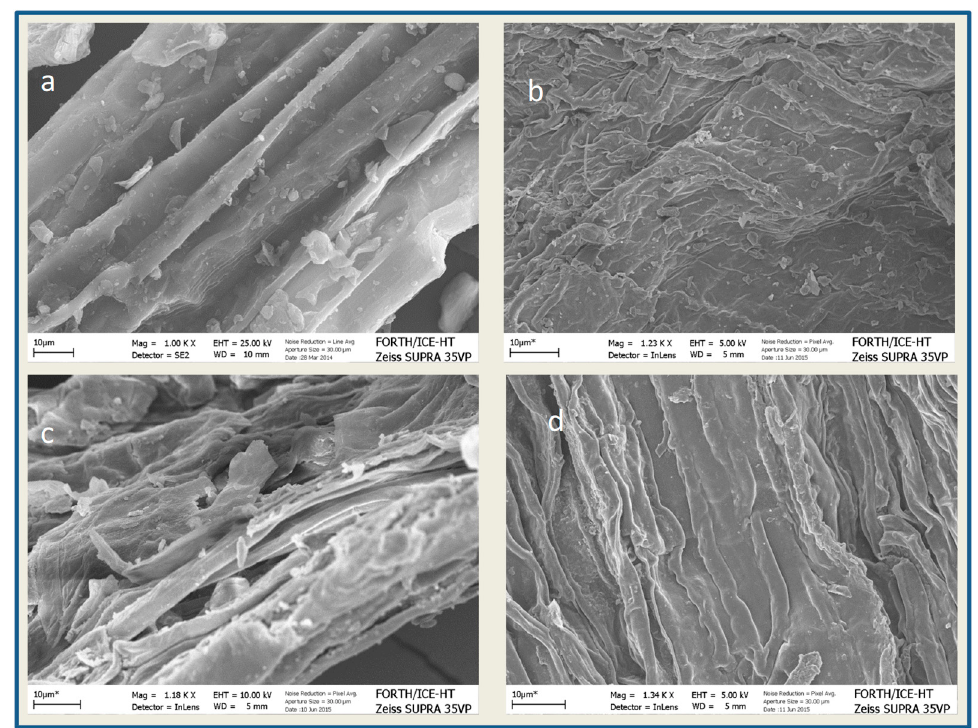
Figure 3. SEM images of raw ( a ), alkali (NaOH) ( b ) acid (H 2 SO 4 ) ( c ) and acid (HCl) ( d ) pretreatment, at the concentration of 20 g/100 gTS, respectively.